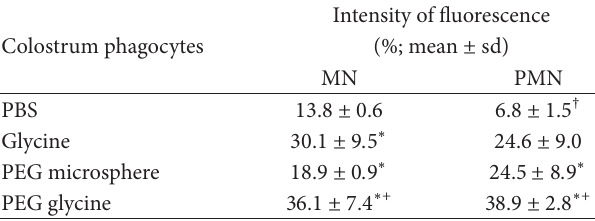
Figure 3: Colostrum mononuclear (MN—panel (a)) and polymorphonuclear (PMN—panel (b)) phagocytes stimulated with glycine were staining with Fluo-3 to assess intracellular Ca 2+ release as described in Section 2. Immunofluorescence analyses were then carried out by flow cytometry (FACScalibur, Becton Dickinson, San Jose, USA).